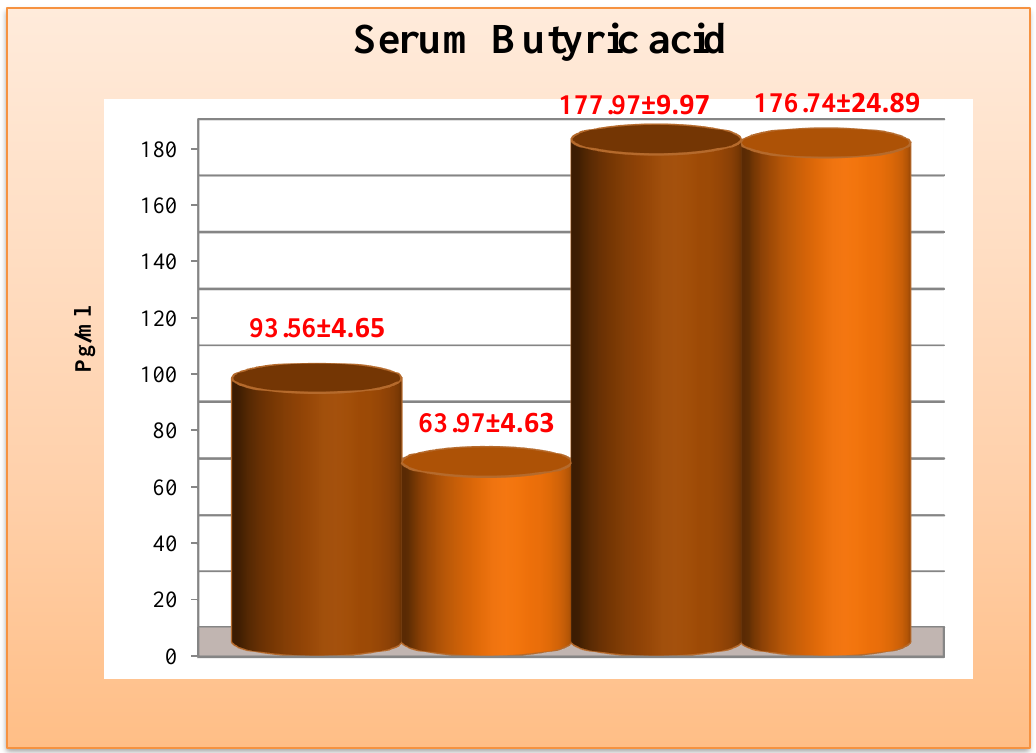
Figure 1. Protective role of synbiotic on serum butyric concentration (pg/ml) against E. coli infection. N=6. Mean±SE. C: control negative group. C++: control positive group. T1: Fenugreek administered to enteritis group. T2: Fenugreek and L. acidophilus administered to enteritis group. Least Significant Difference (LSD) of butyric acid =